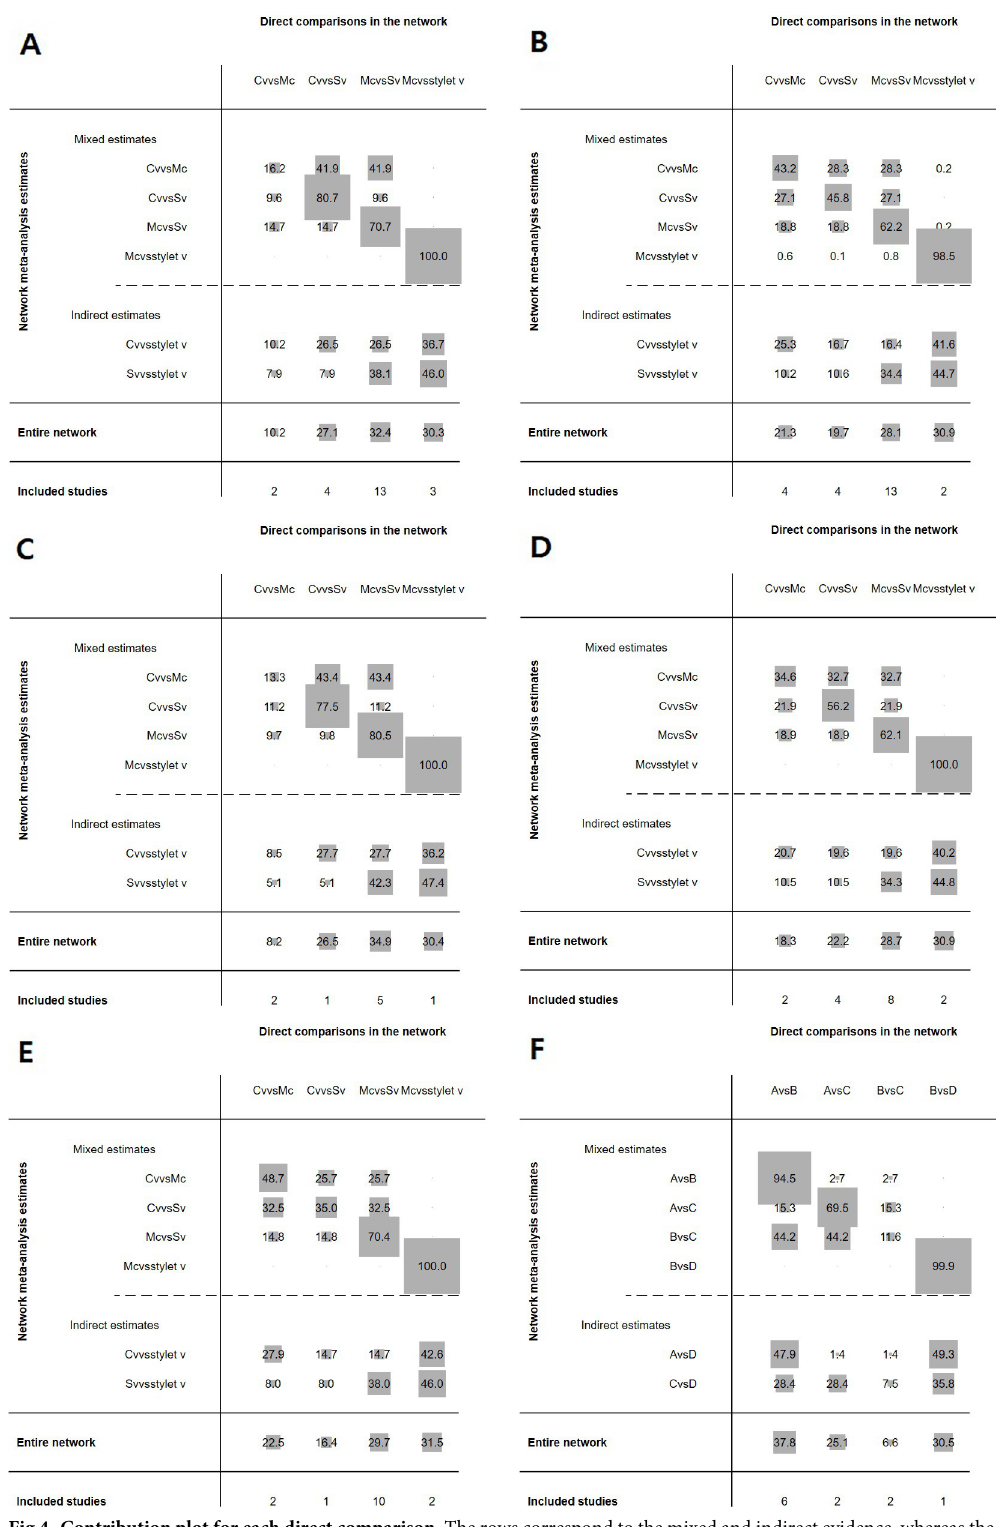
Fig 4. Contribution plot for each direct comparison. The rows correspond to the mixed and indirect evidence, whereas the columns correspond to the direct evidence. The percentage contribution of each direct comparison to the network summary is presented in the entire network row. The sizes of the boxes are proportional to the percentage contribution of each direct